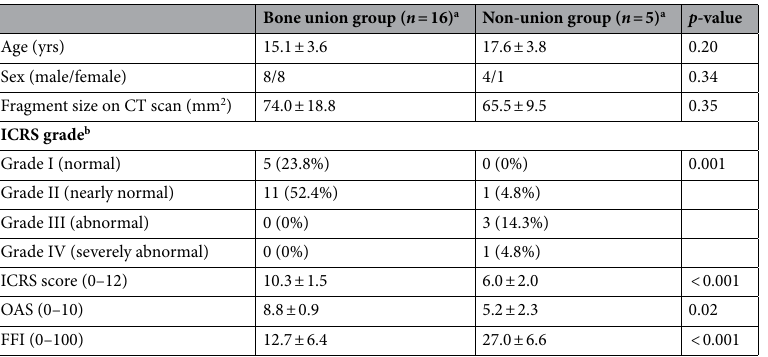
Table 1. Comparison of the second-look arthroscopic findings between the patients with bone union and nonunion after internal fixation. a Values are given as the mean ± standard deviation, with the exception of sex and ICRS grade. b Values are given as the number and the percentage in parenthesis. ICRS International Cartilage Repair Society (total score of 12 points, with 12 being the best), OAS Oswestry Arthroscopy Score (total score of 10 points, with 10 being the best), FFI Foot Function Index (total score of 100 points, with 100 being the worst).